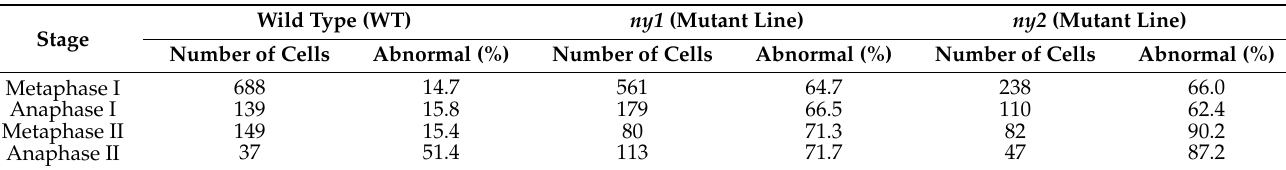
Table 3. Frequency of pollen mother cells with abnormal chromosome behavior during meiosis in WT, ny1 and ny2 mutant